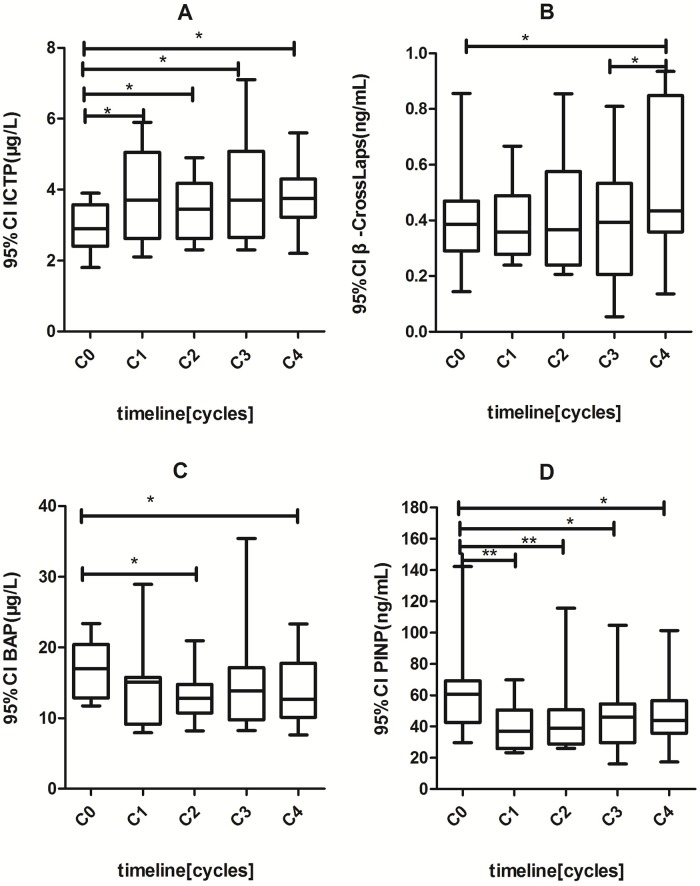
Changes of serum bone turnover markers levels under different cycles of chemotherapy in post-menopausal breast cancers.(*) p< 0.05; (**) p<0.01. C0: the day of initial diagnosis; C1–C4: 24 hours after the first, second, third. Fourth cycle of chemotherapy.